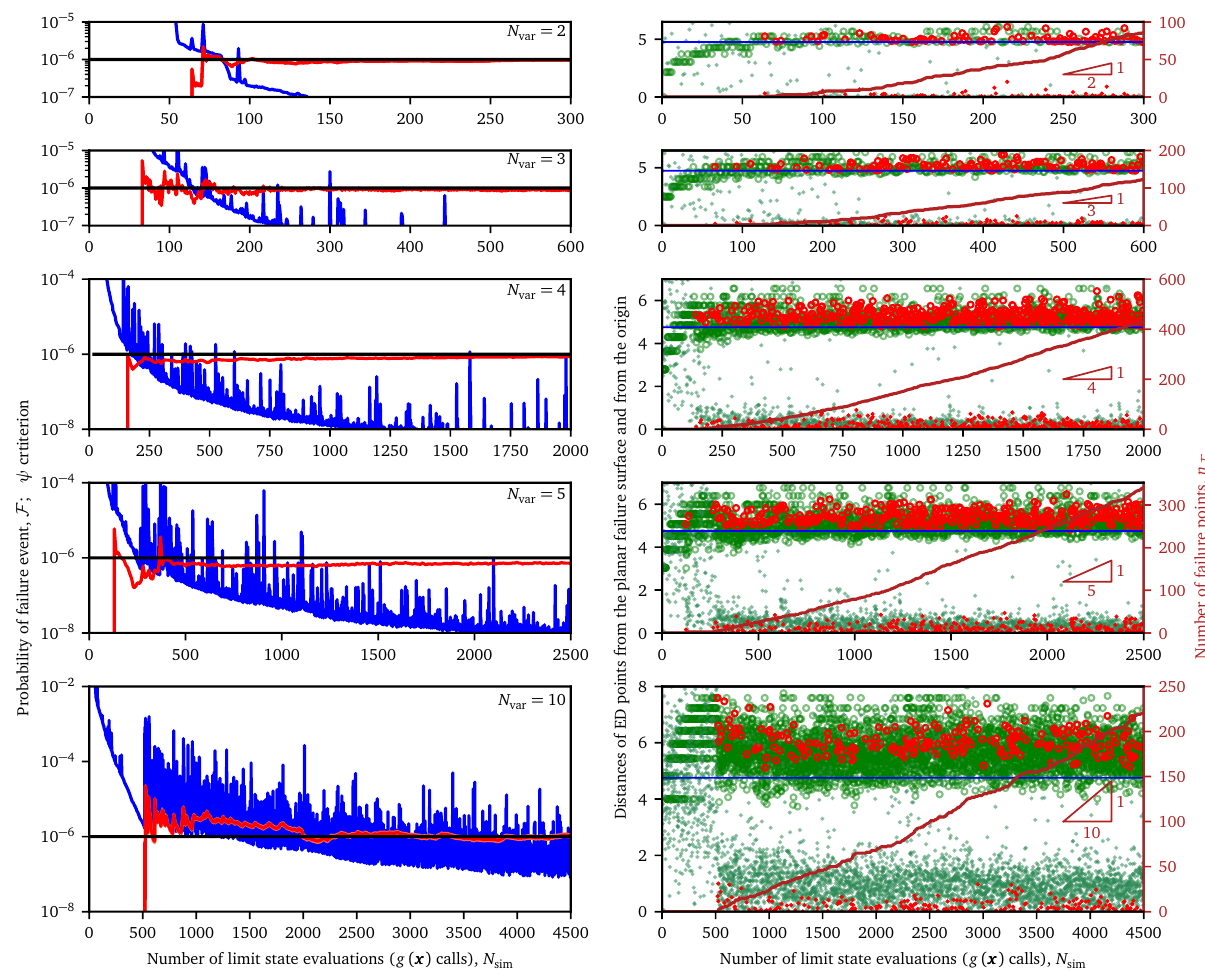
Figure 9. Recorded histories of exploration and estimation for the ”Linear Failure Surface” problem in Eq. (23) studied for N var = 2, 3, 4, 5 and 10 (rows). The left column reports histories of the ψ criterion and the estimated p ( N sim ) . The right column reports the radial distances of ED points from the origin (empty circles), as well as F distances from the planar failure surface (small diamonds). The secondary vertical axis shows the number of failure points. The complete evolution of ED extension in N var = 2 and 3 dimensions is shown in video 2D and video 3D